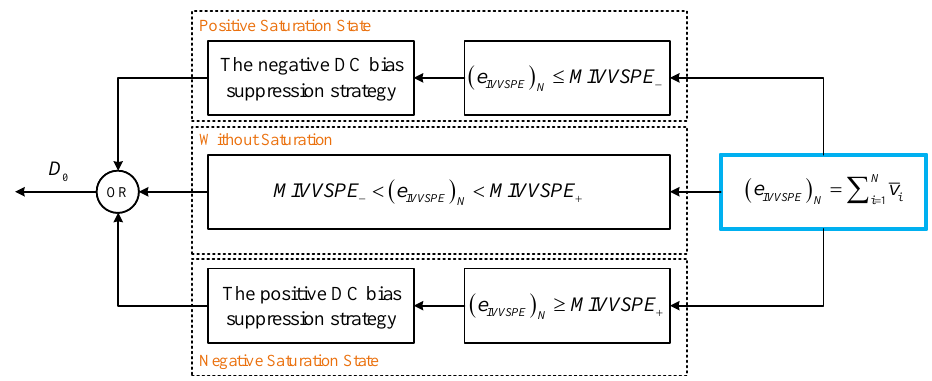
Figure 11. The block diagram of the DC bias suppression strategy.